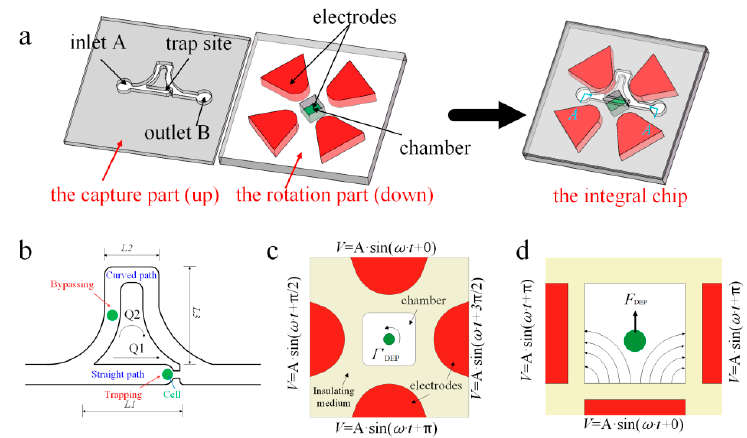
Figure 1. The design and theory of the integrated chip. ( a ) The separate view of the integrated model. ( b ) The schematic of the microchannel. ( c ) The top view of electrode chamber regarding dielectrophoresis (DEP) torque. ( d ) The side view of electrode chamber regarding DEP force.